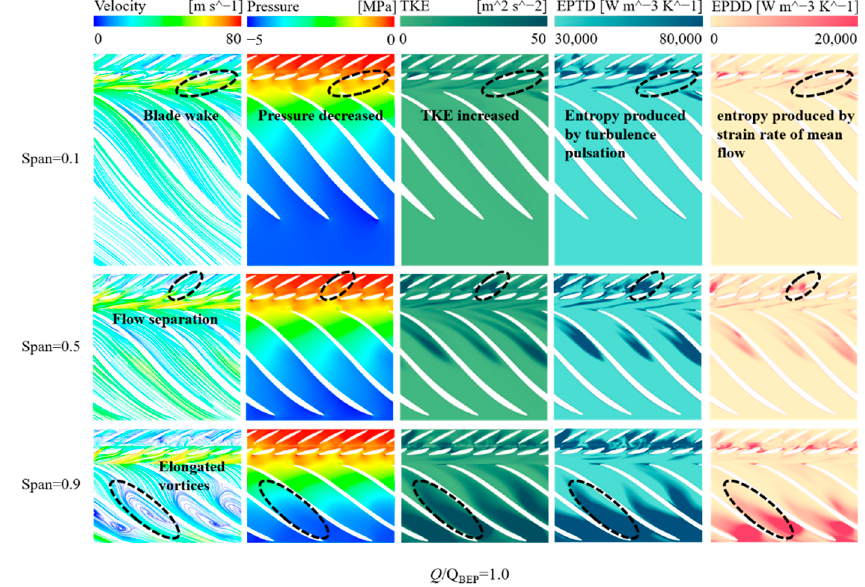
Figure 10. Distribution of the entropy production under BEP conditions (1.0Q BEP ).